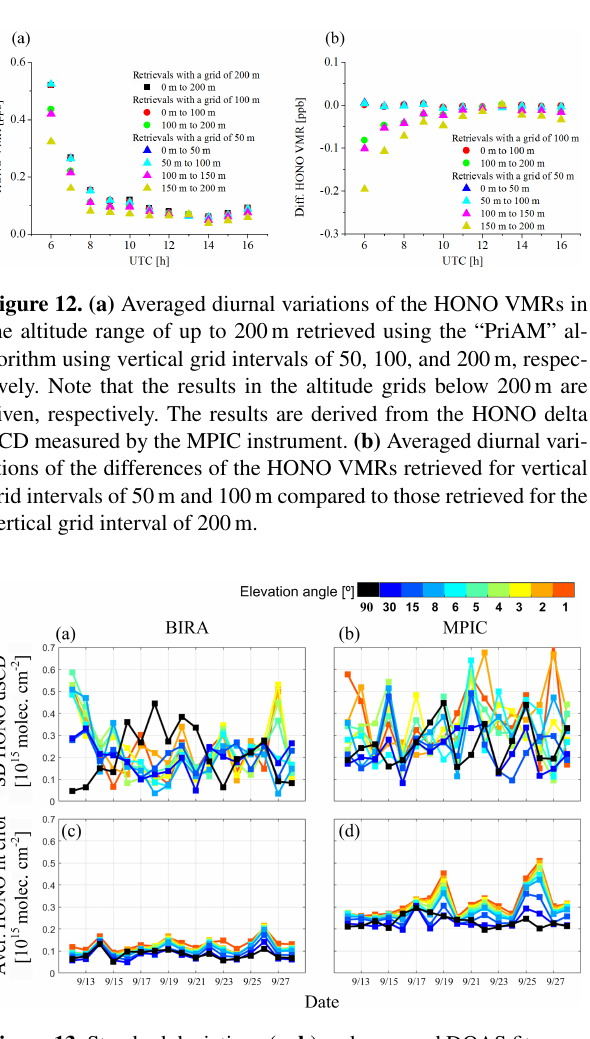
Figure 13. Standard deviations (a, b) and averaged DOAS fit errors (c, d) of HONO dSCDs retrieved using the daily noon FRS in the time period of 11:00 to 16:00UTC for individual days for the BIRA (a, c) and MPIC (b, d) instruments, respectively. The colour map indicates elevation